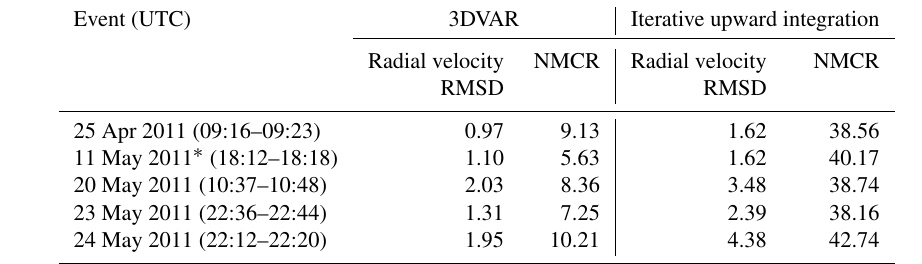
Table 4. C-SAPR radial velocity RMSD and NMCR from the 3DVAR and iterative upward integration techniques.